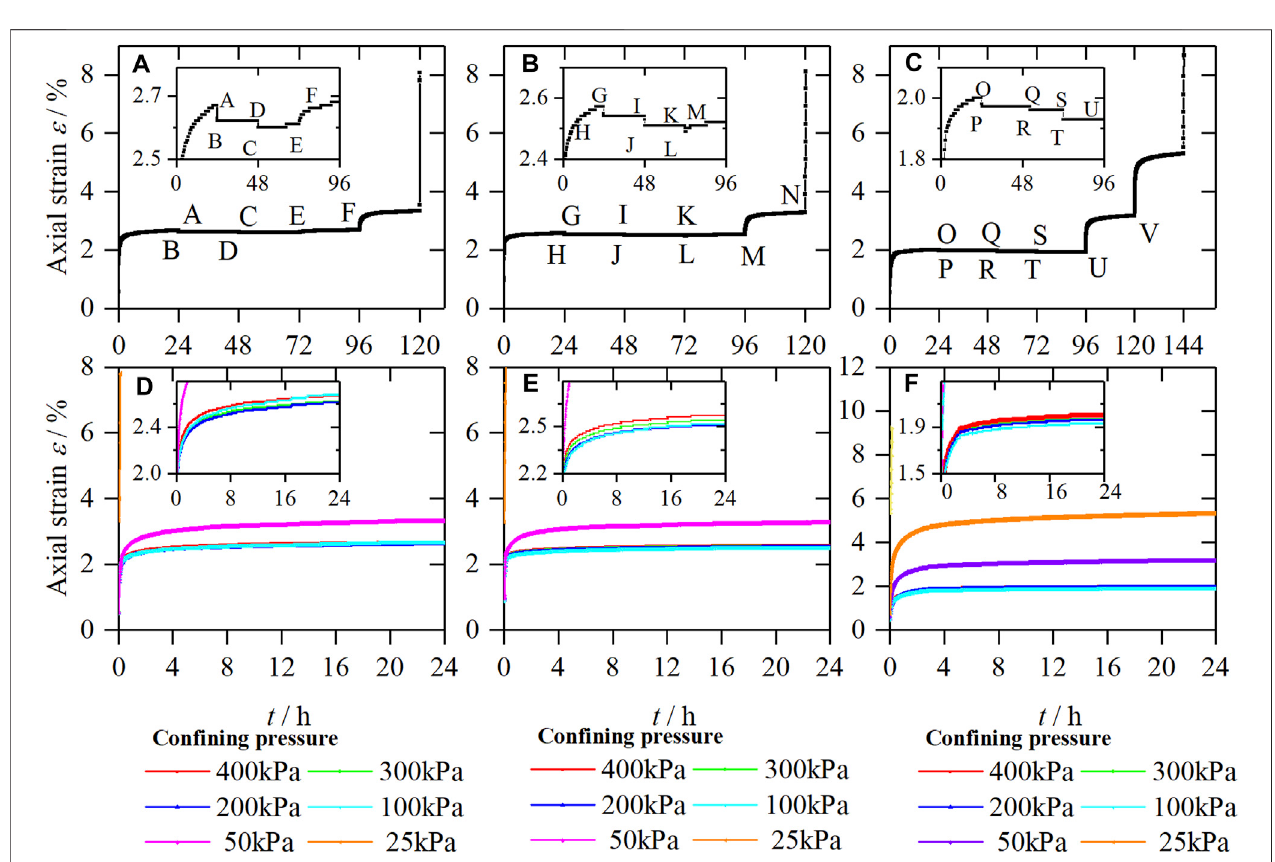
FIGURE 5 | Strain-time curves of samples, (A) UC-1, (B) UC-2, (C) UC-3, and creep curves of samples, (D) UC-1, (E) UC-2, (F) UC-3.